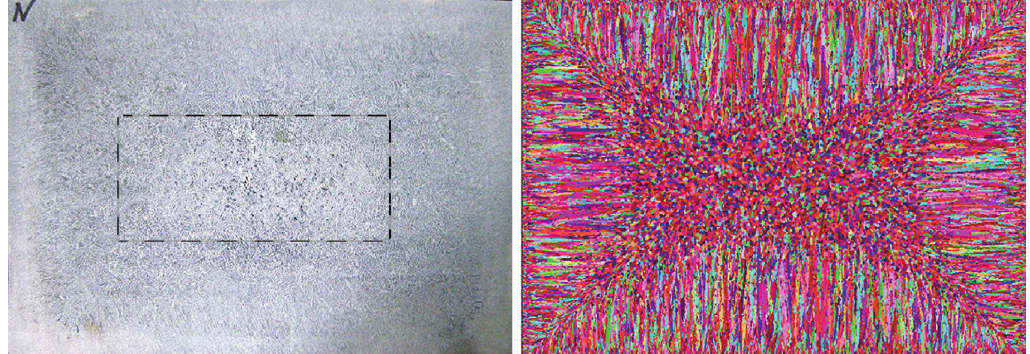
Fig. 3: Observed (left) and simulated (right) macrostructure